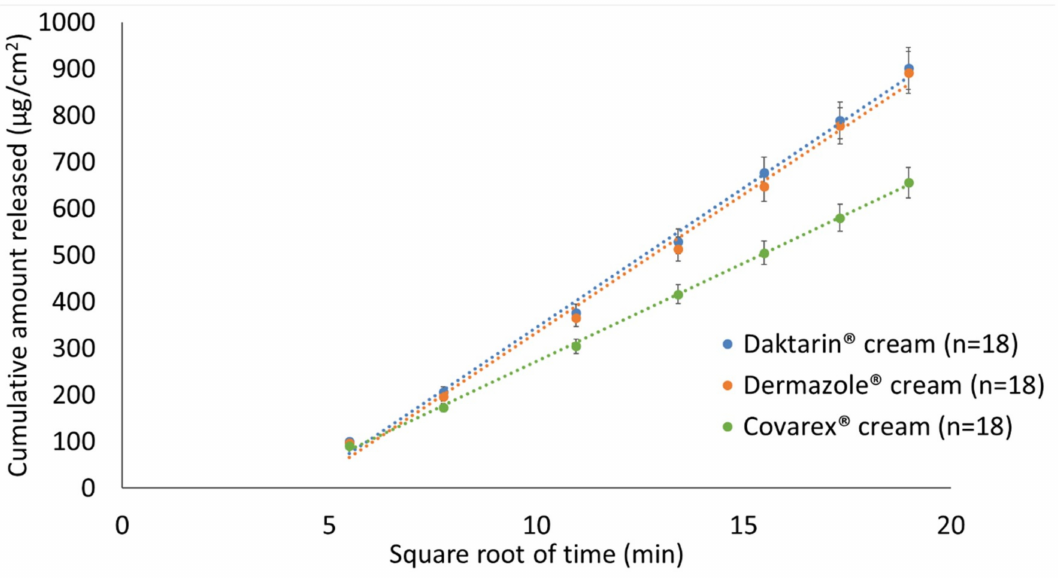
Figure 3. Comparison of the release profiles of marketed creams, Dermazole ® cream (2%) and Covarex ® cream (2%) against the reference product, Daktarin cream